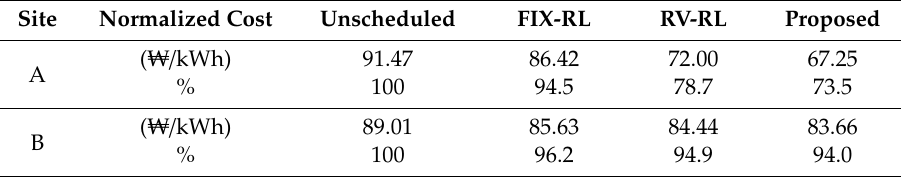
Table 2. Normalized total cost over test